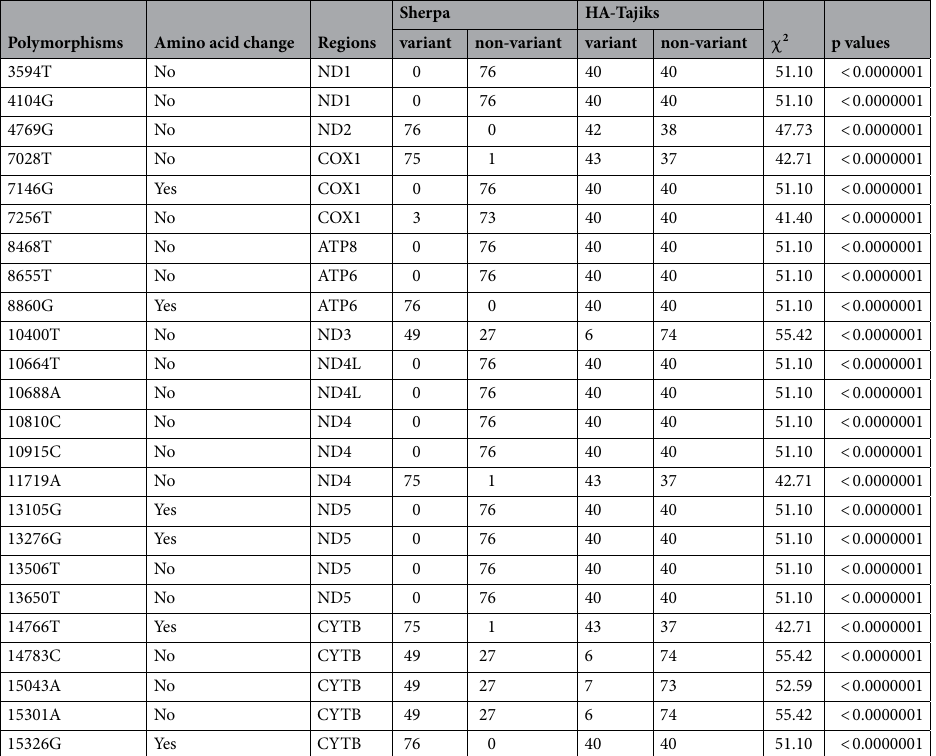
Table 3. Results with p values below 0.0000001 in the comparison of the mtDNA genome between Sherpas and HA-Tajiks.